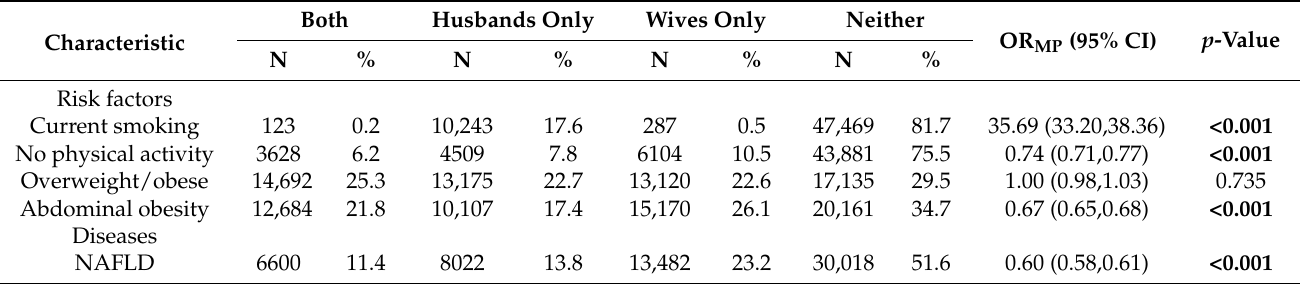
Table 2. Spousal concordance for lifestyle factors and NAFLD among the 58,122 married